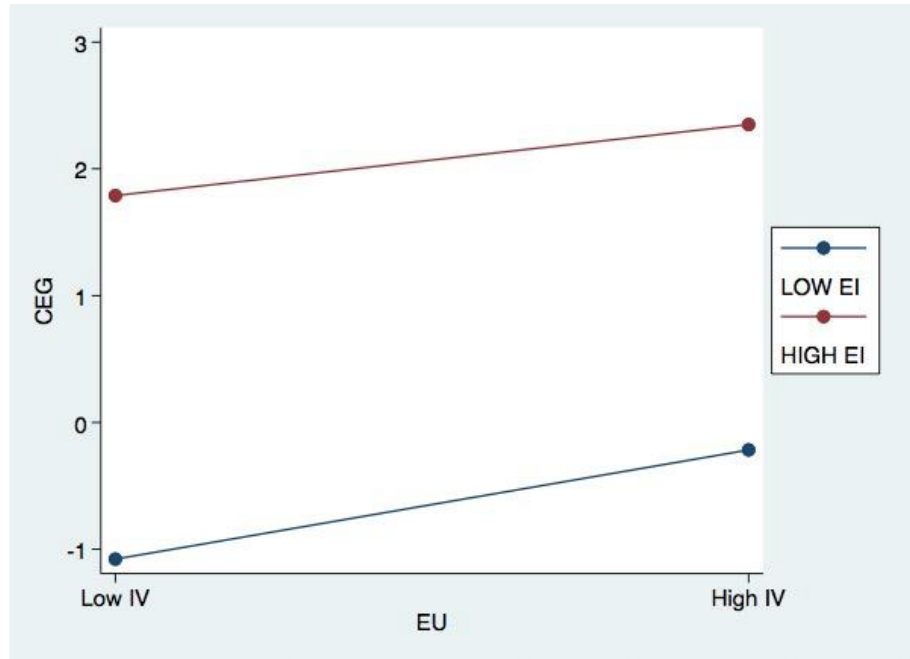
Figure 2. Effects of EI on the relationship between EU and CEG.